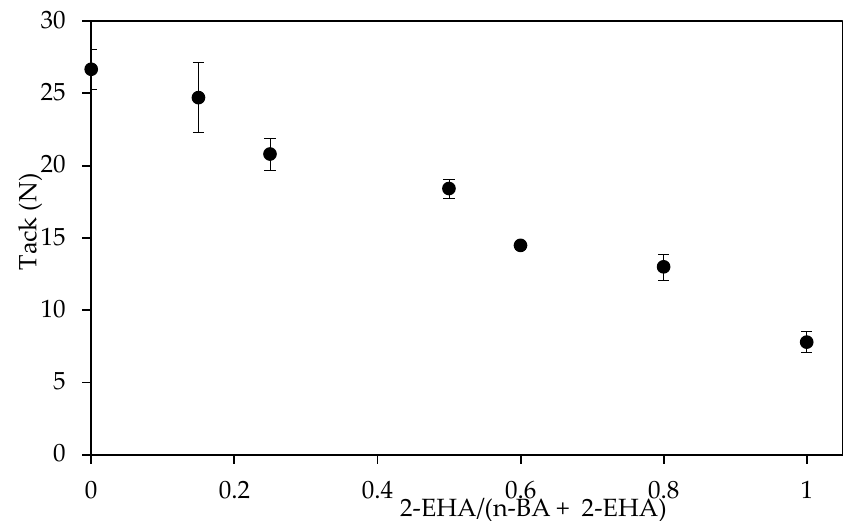
Figure 11. The effect of the co-monomer ratio in the loop tack test using PET tapes on glass panels.